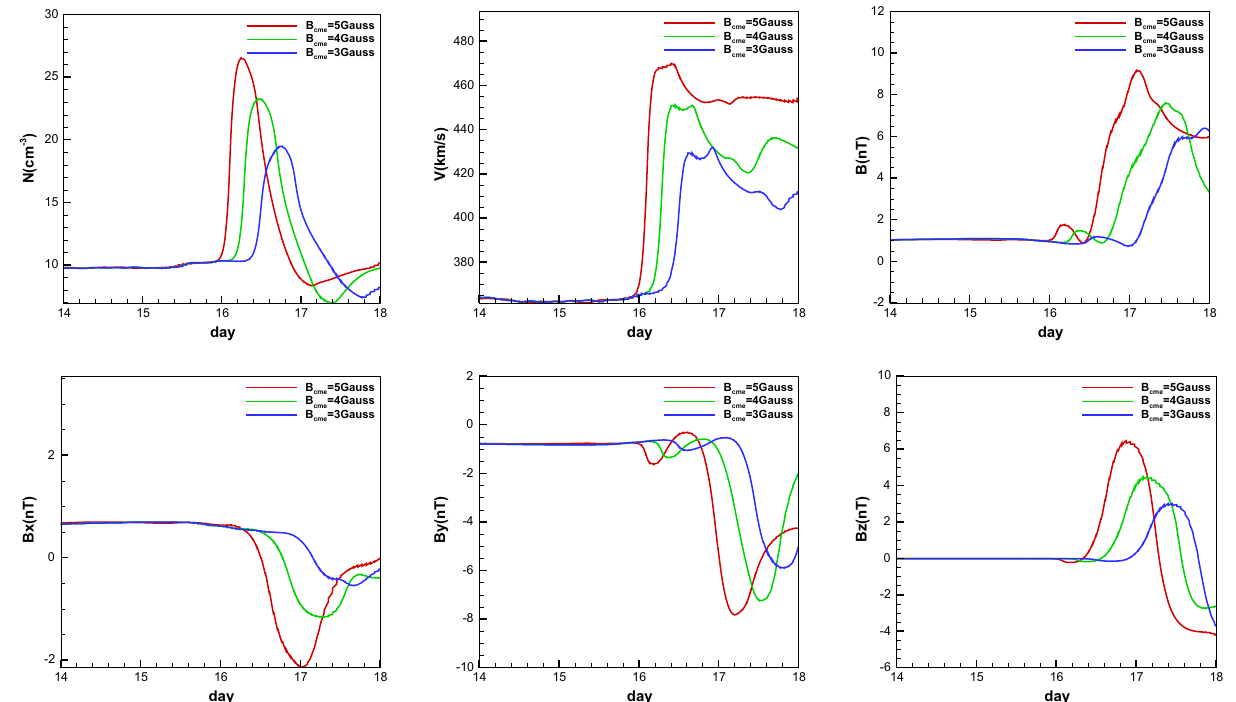
Fig. 15. Evolution of solar wind parameters at the Earth with different magnitude of magnetic fi elds in the CME. The fi rst row present the number density (left), fl ow velocity (middle), magnetic fi eld (right), and the second row are the three components of magnetic fi eld ( B x , B y , B z ) in GSE